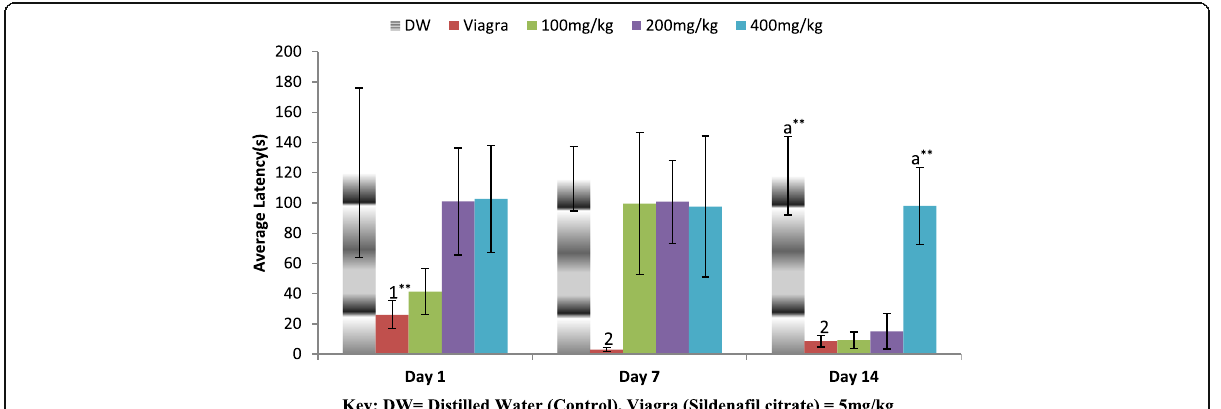
Fig. 3 Effect of ethanol extract of A. barbadensis root on mount latency of male rats. Bars with dissimilar letters are significantly different; bars with letters are significantly different from bars without letters while those with no letters are not significantly different from each other on each day. Bars with different numbers for the same dose group at different days are significantly different while those without numbers are not significantly different. All values are expressed as Mean ± SEM; n = 5;** P < 0.01; * P < 0.05